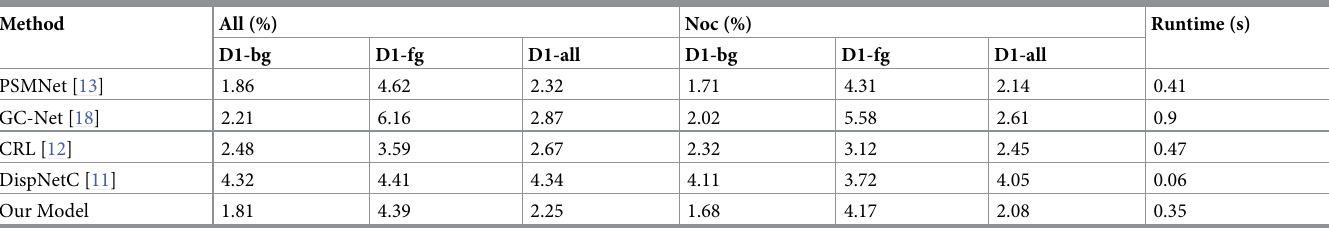
Table 6. KITTI 2015 quantitative assessment results.